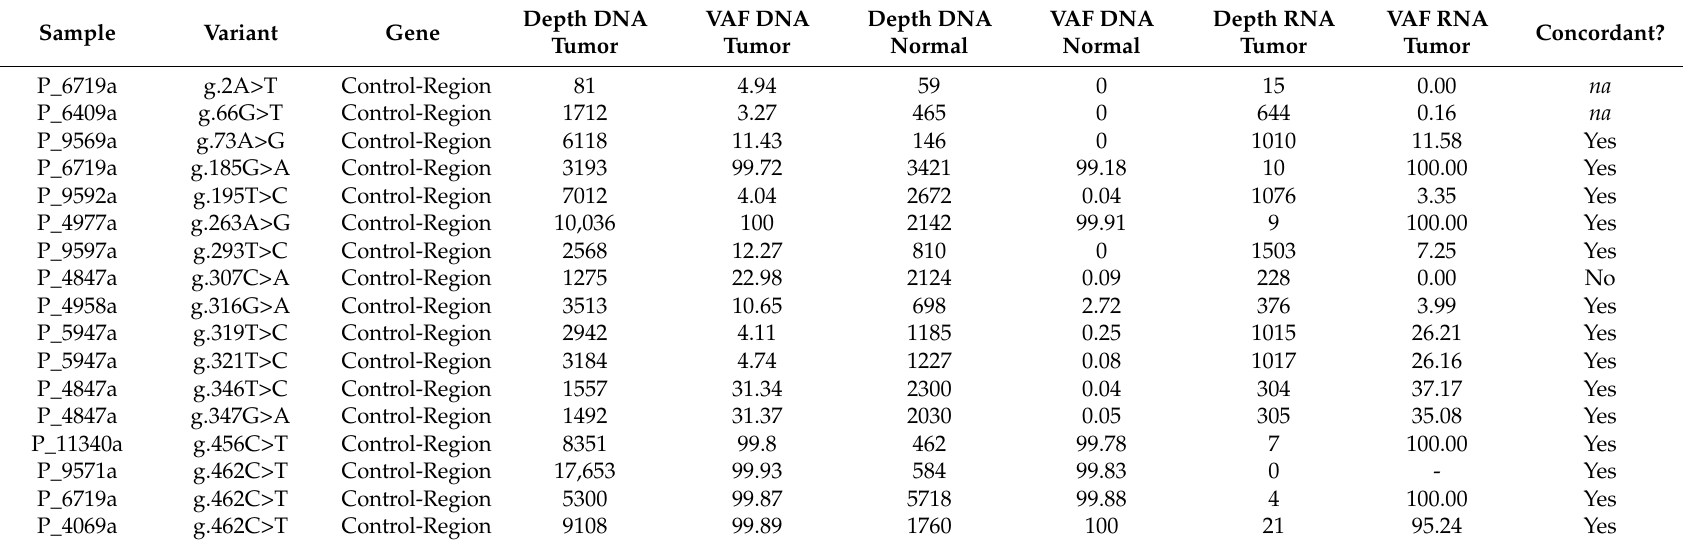
Table A2. Variants called at only the mtDNA